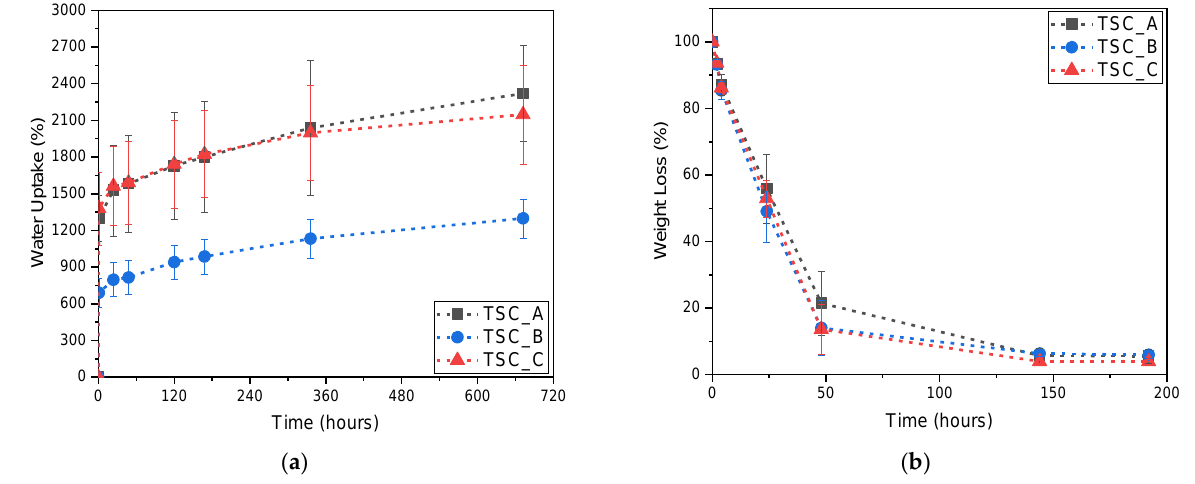
Figure 5. Evaluation of the ( a ) water uptake and of the ( b ) weight loss for the prepared xanthan gum-based TSC.